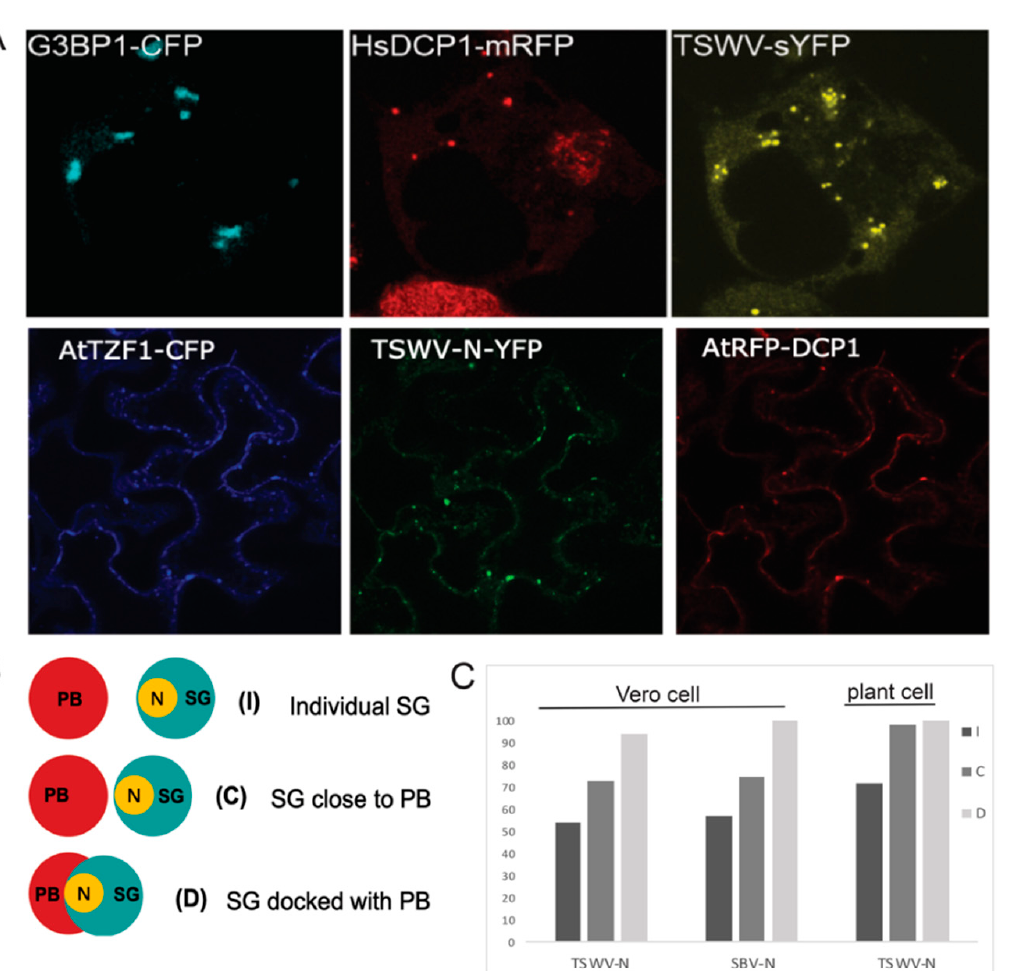
Figure 3. Localization and quantification of N proteins relative to individual PB and SG marker proteins, and PB-SG docking stages. ( A ) Images of TSWV N protein expression in Vero cells, sub- jected to arsenite treatment for SG-induction, showing the spatial distribution of N protein relative to PB and SG markers (Upper panel). Images of TSWV N protein expression in N. benthamiana cells, subjected to a heat shock for SG-induction, showing the spatial distribution of N protein relative to PB and SG markers (lower panel). ( B ) Graphical description of different patterns of N protein asso- ciated with SG in different connections to PB (Left panel). The indication “I” represents individual SG distant from PB, “C” represents SG close to PB. “D” represents SG docked on PB. ( C ) Quantifi- cation of transiently expressed TSWV and SBV N protein associated with different types of SG, as defined in panel B, in Vero cells, and of TSWV N protein in plant cells. ( D ) Quantification of PB and SG association types in plant cells after TSWV infection + heat shock and after heat shock only (up- per half of the panel) and quantification of PB and SG association types in animal cells after SBV infection and after arsenite treatment (lower half of the panel).